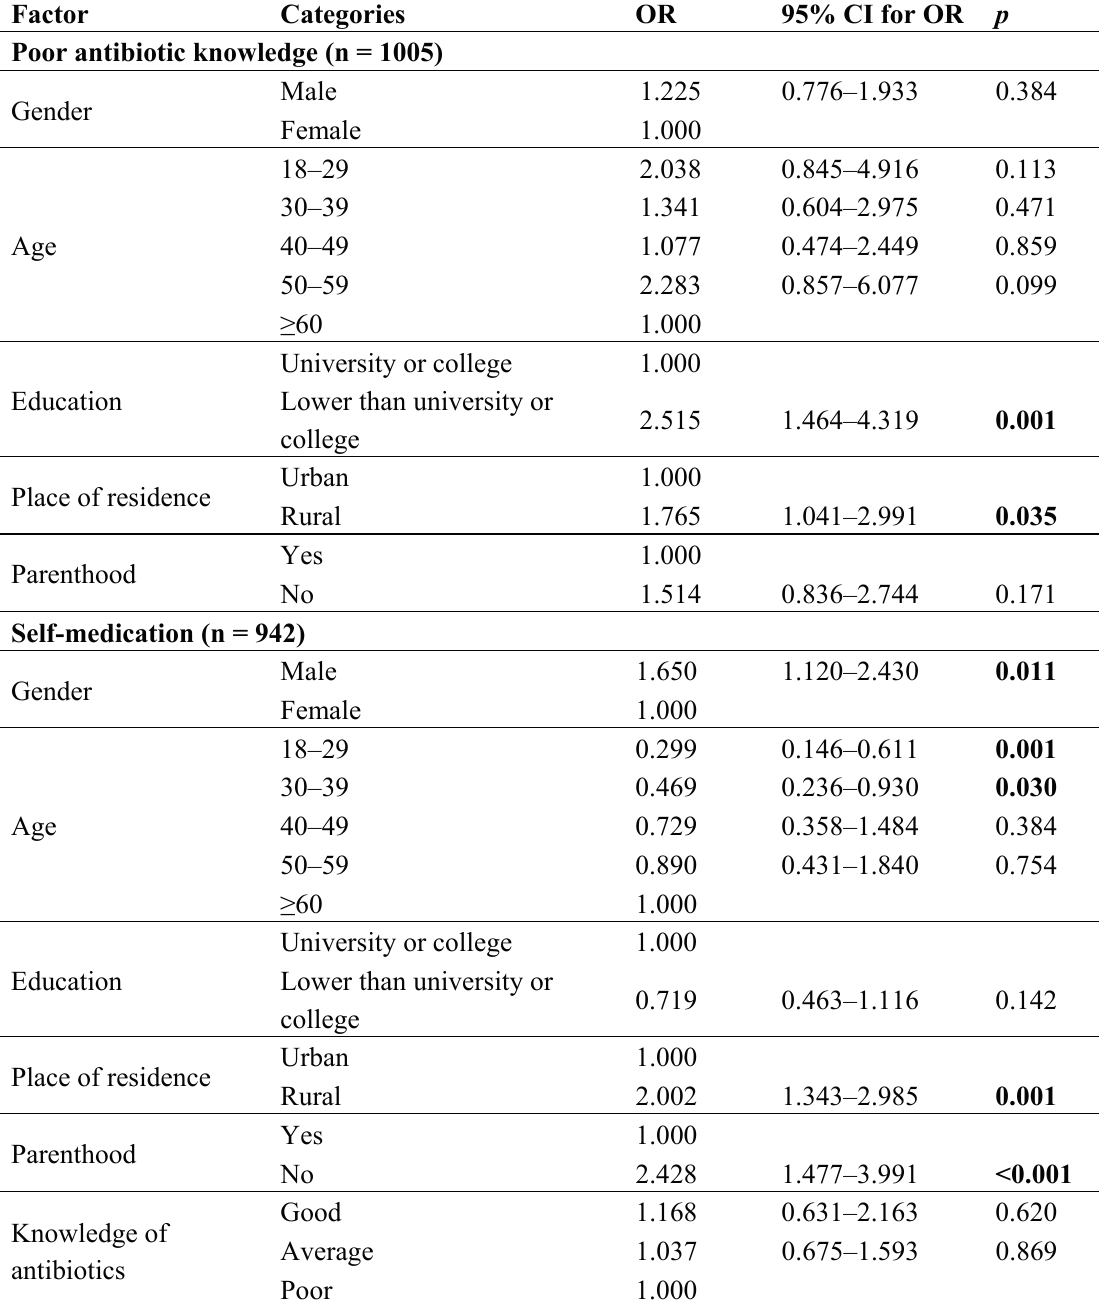
Table 4. Multivariate logistic regression analysis of factors independently associated with poor knowledge of antibiotics and